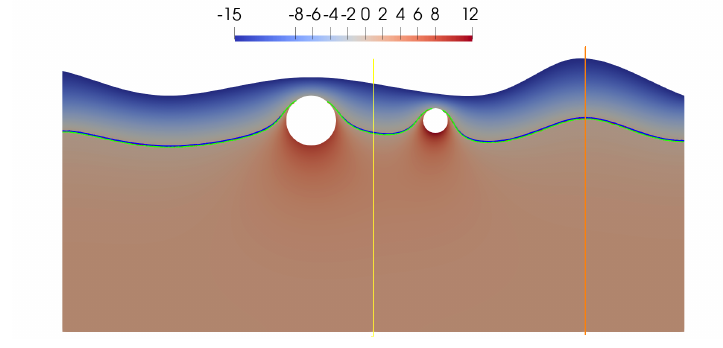
Figure 7. Geometry with the unstructured grid for g = − 5. Numerical solutions using error function smoothing (blue color), smoothing in one spatial interval (red color), and linear smoothing using the ∆ interval (green color). Yellow line: x 1 = 2.5. Orange line: x 1 = 4.2.